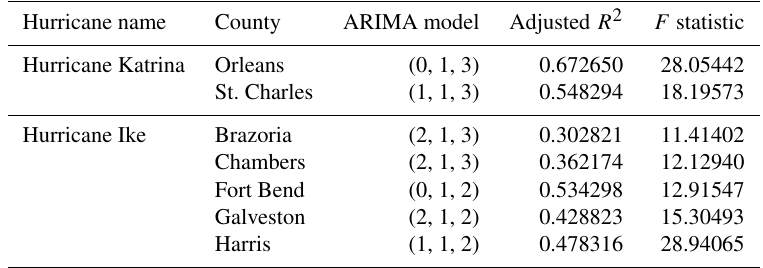
Table 2. ARIMA model